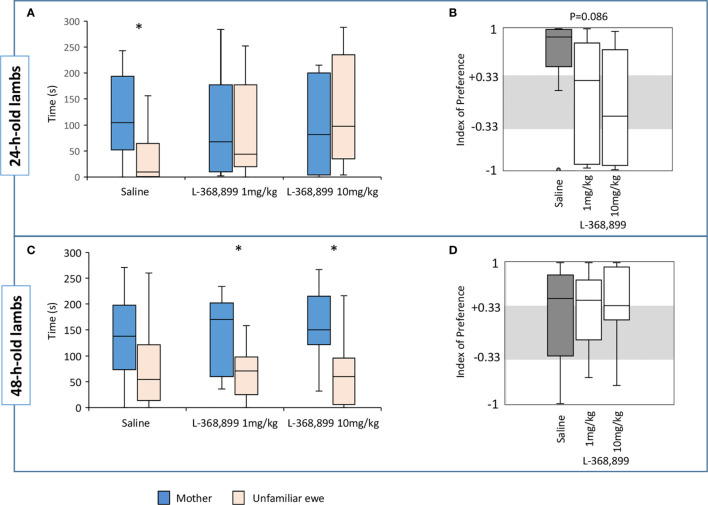
Time(s) spent in the contact zone near the mother or the unfamiliar ewe in the choice test by lambs when 24 h (A) and 48 h old (C). At birth, lambs had unlimited access to the mother’s udder and received either saline (n=10) or L3688-899 at 1 mg (n=11) or 10 mg/kg (n=11) via orogastric tubing. Treatments were administered at birth, and then 2 and 4 h later. Indexes of preference (IP) in 24 h (B) and 48 h old lambs (D). IP>+0.33: preference for the mother; +0.33<IP<-0.33: no preference; IP<-0.33: preference for the unfamiliar ewe. Data are expressed as medians and 1st and 3rd quartiles. Paired box-plots associated with a star (*) are significantly different (p<0.05).